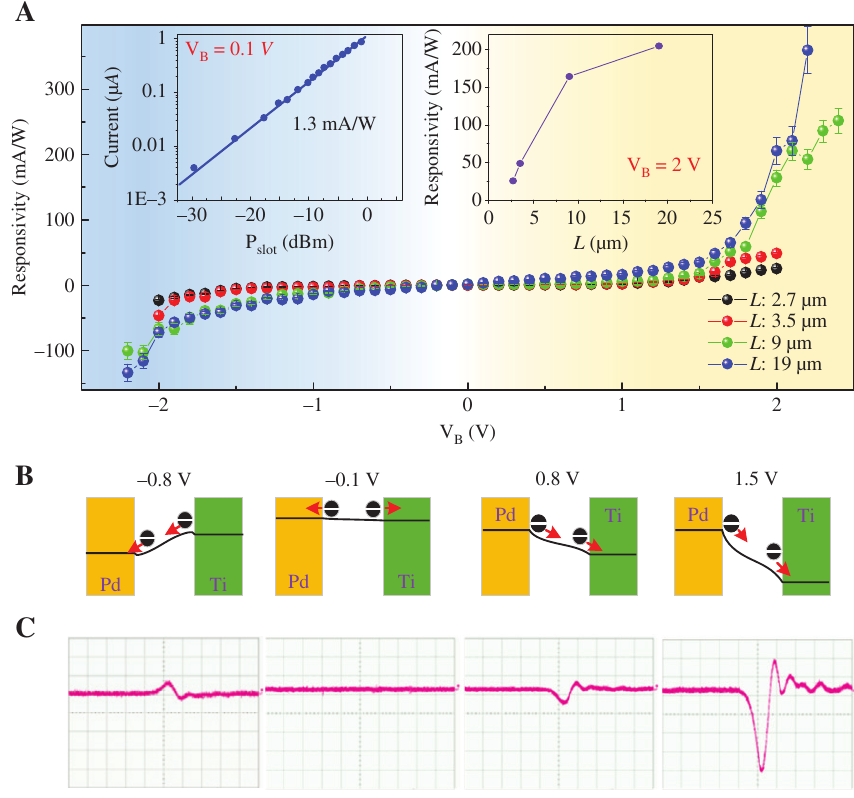
Figure 3: Characterization of responsivity of the devices. (A) Measured responsivity at different bias voltages for four devices with different L . The insets show the measured photocurrent as a function of the light power with zero bias, as well as the responsivity versus the graphene coverage length L with bias voltage of 2 V. (B) Schematics of the potential profiles at different biases. (C) The corresponding measured output electrical signals for the photodetector with graphene coverage length L of 19 μ m. The time scale is 20